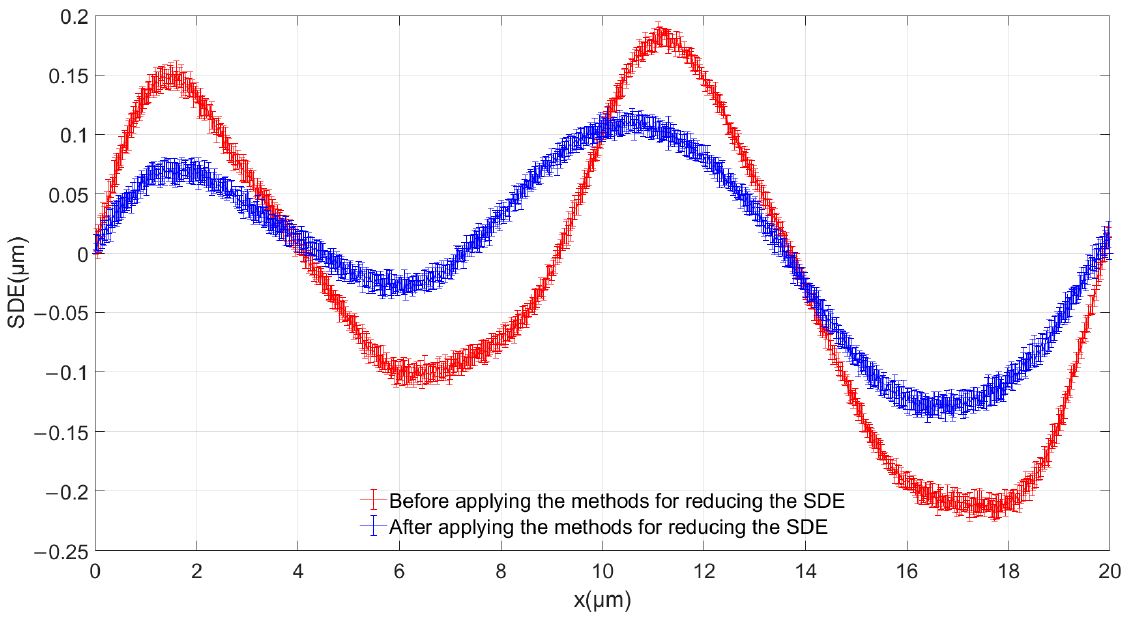
Figure 11. Comparison of SDE. Table 1. Proportion of higher-order